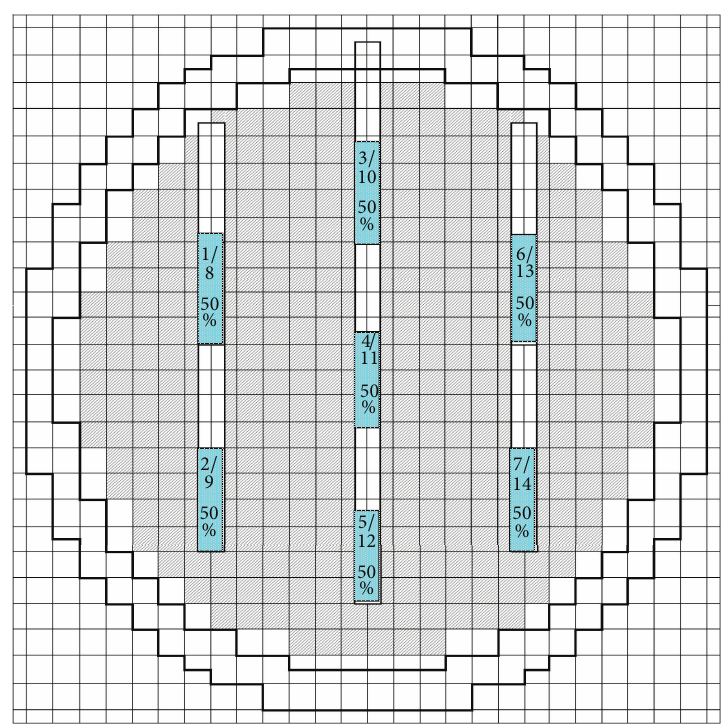
Figure 3: Front view of the CANDU 6 core showing